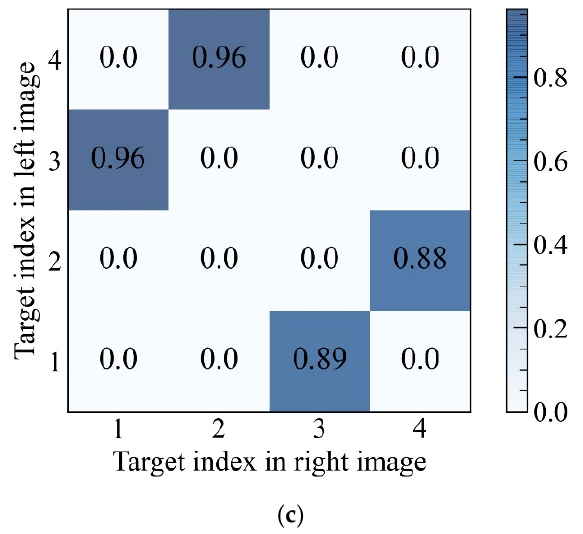
Figure 7. Detection and stereo matching results of the left and right image, ( a ) the left image, ( b ) the right image, ( c ) the MS matrix.